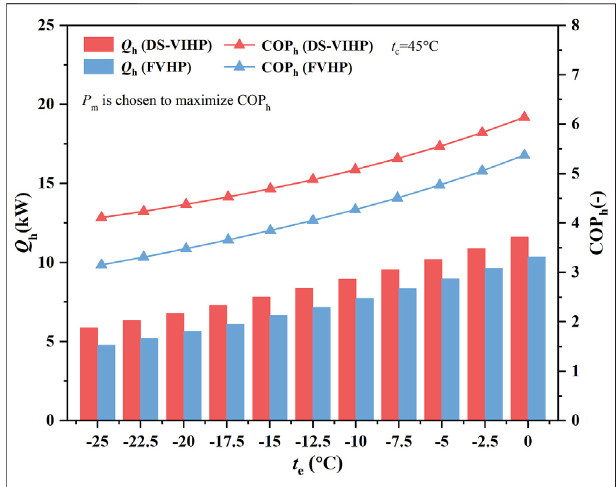
FIGURE 5 | Performance comparison under different evaporating